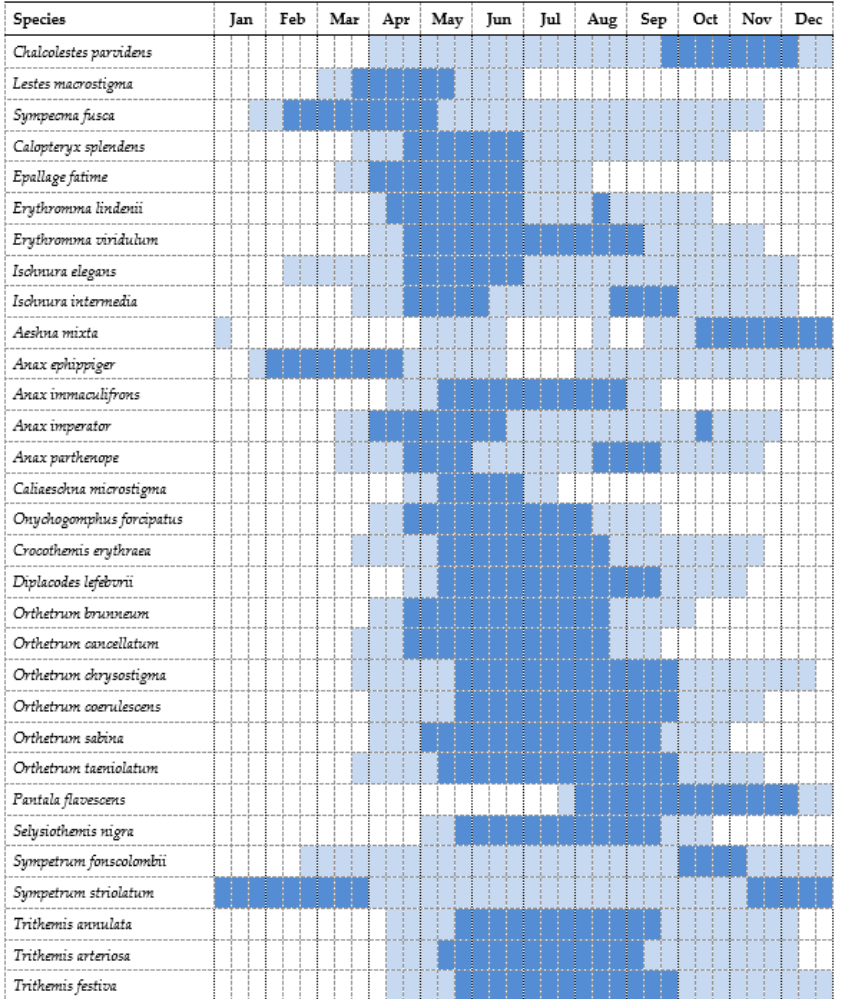
Figure 3. The flight season of the Odonata present in Cyprus based on records for the period 2013 to 2019. Flight season (light shading) and main flight season (dark shading).